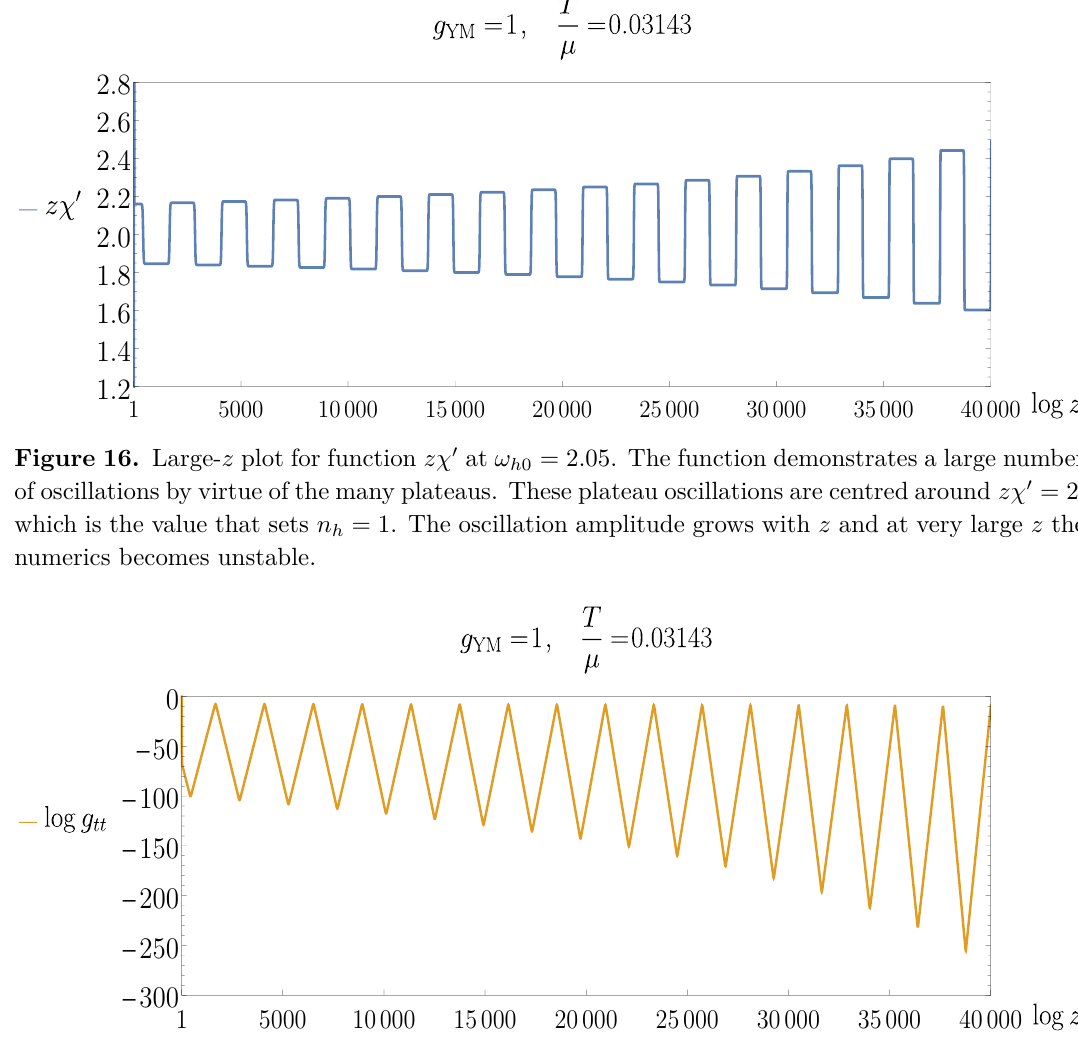
Figure 17. Large- z plot for function log g tt at ω h 0 = 2 . 05 . The function demonstrates a large number of oscillations. The oscillation amplitude grows with z